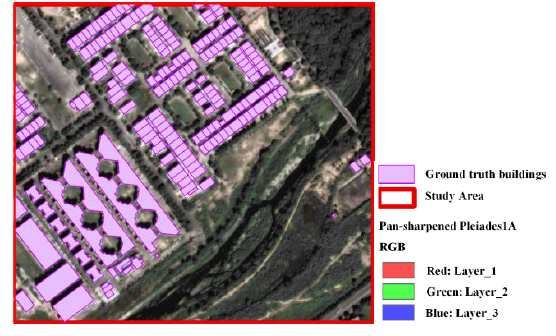
Figure 18. Ground truth buildings